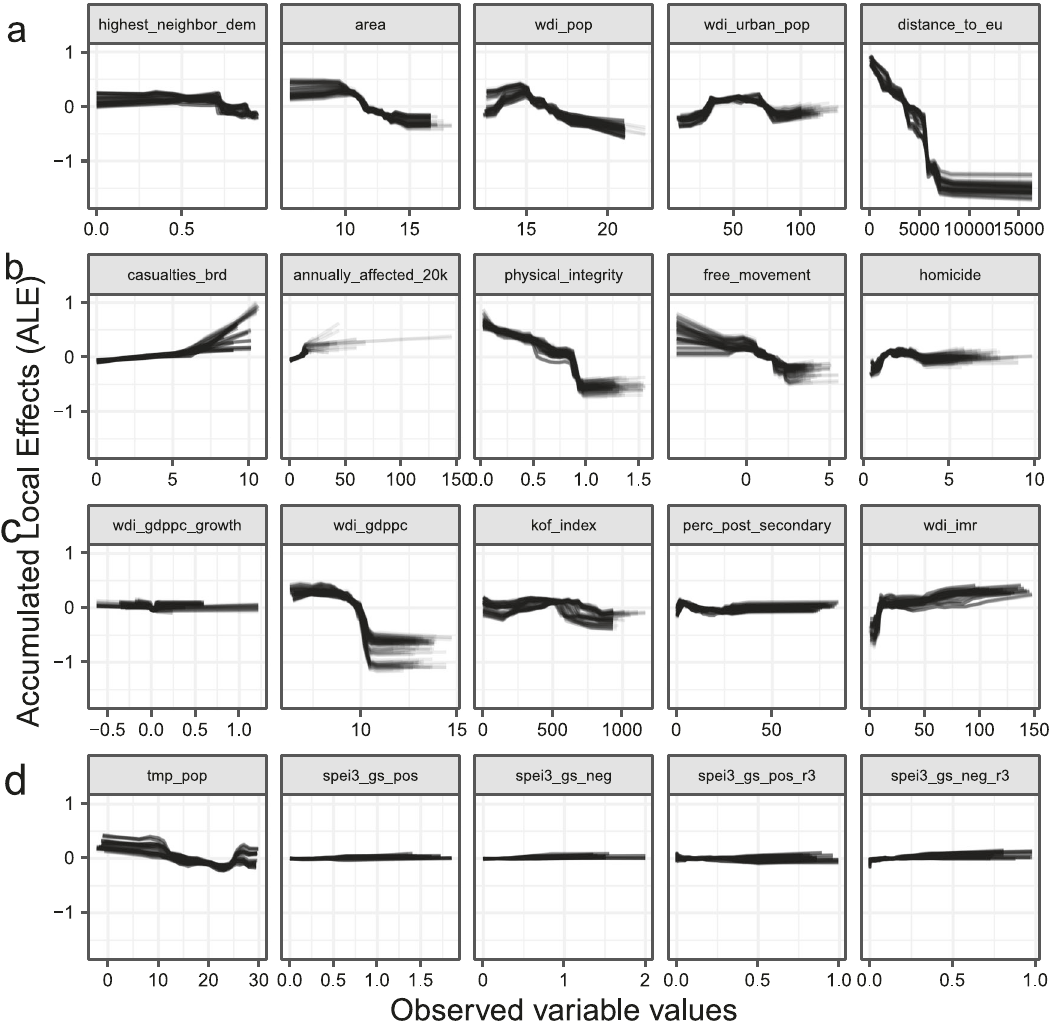
Fig. 4 Accumulated Local Effects (ALEs) of asylum migration predictors. a Baseline component indicators. b Violence component indicators. c Economy component indicators. d Climate component indicators. ALEs give the marginal difference in prediction with an incremental change in the predictor. Y axis values represent change in log asylum applications per capita. The results in a – d are generated from leave-future-out cross-validation, trained on alternative 4-year subsets of empirical data for the period 1999 – 2017, and tested against observed outcomes for the subsequent year 2003 – 2018. N = 3413 country-year observations, examined over 160